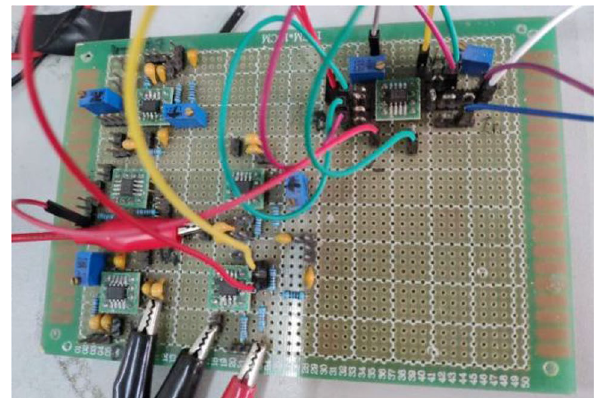
Figure 10. Photo of the feedback control circuits.